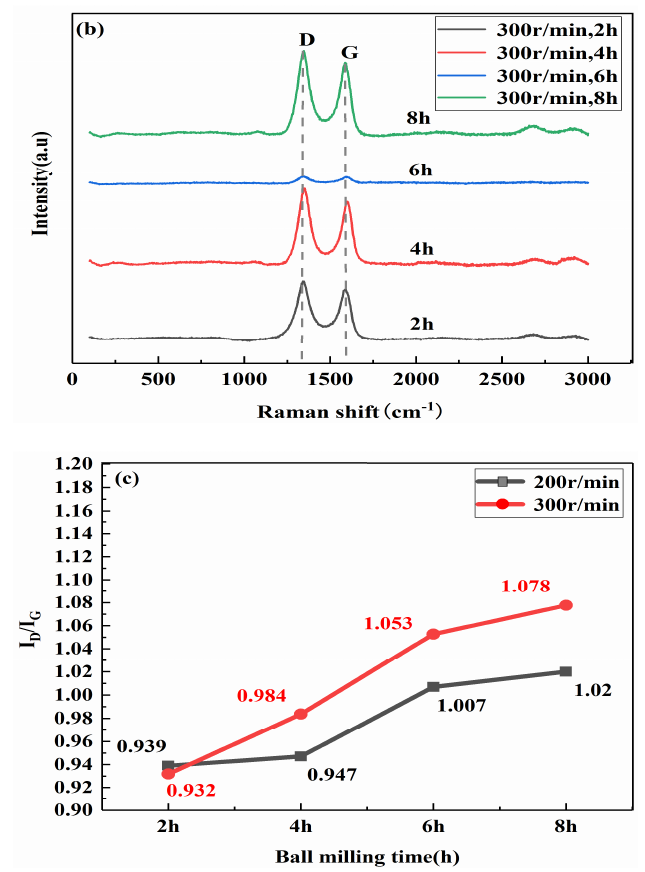
Figure 8. Raman spectra of the composite with different ball milling times. ( a ) Roman shift, 200 r/min; ( b ) Roman shift, 300 r/min; ( c ) I D /I G .